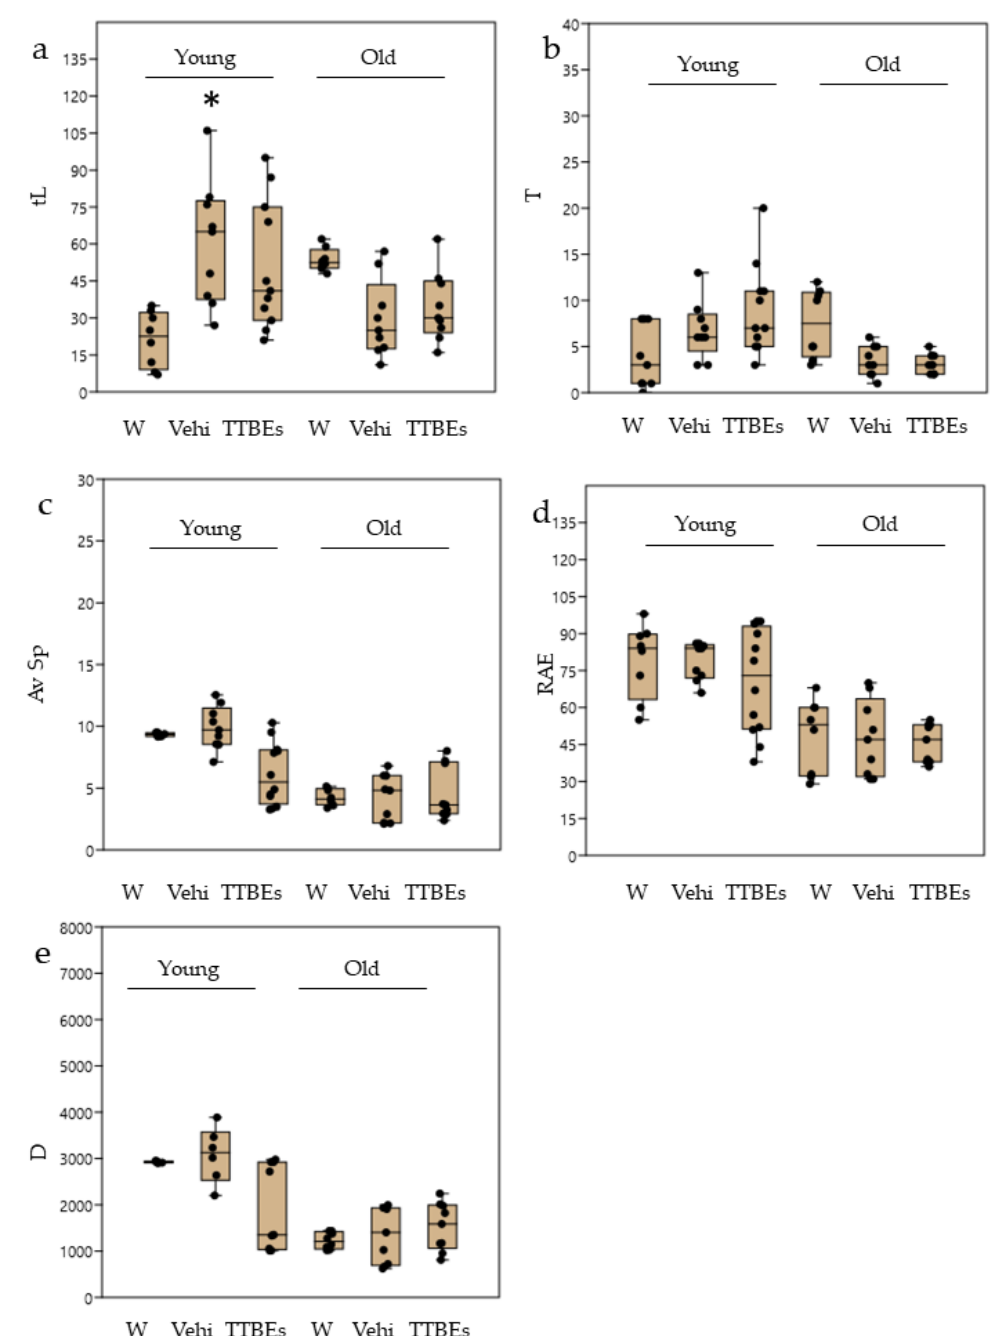
Figure 9. Light Dark test in young and old female mice: e ff ects 21 days of dietary integration with vehicle, TTBEs respect to water. Behavioral skills were quantified as ( a ) time in light (tL), ( b ) n ◦ of transitions (T), ( c ) average speed (Av Sp), ( d ) exploration rate % (RAE) and ( e ) total distance (D). Data represent the mean ± S.E.M. ( n = 8 (W), 9 (Vehi) 12 (TTTBEs) young and ( n = 6 (W), 9 (Vehi) 9 (TTTBEs) old mice analyzed in three di ff erent trials. Statistical analysis was performed by applying ANOVA followed by the Tukey’s multiple comparison test. * p < 0.05 water.